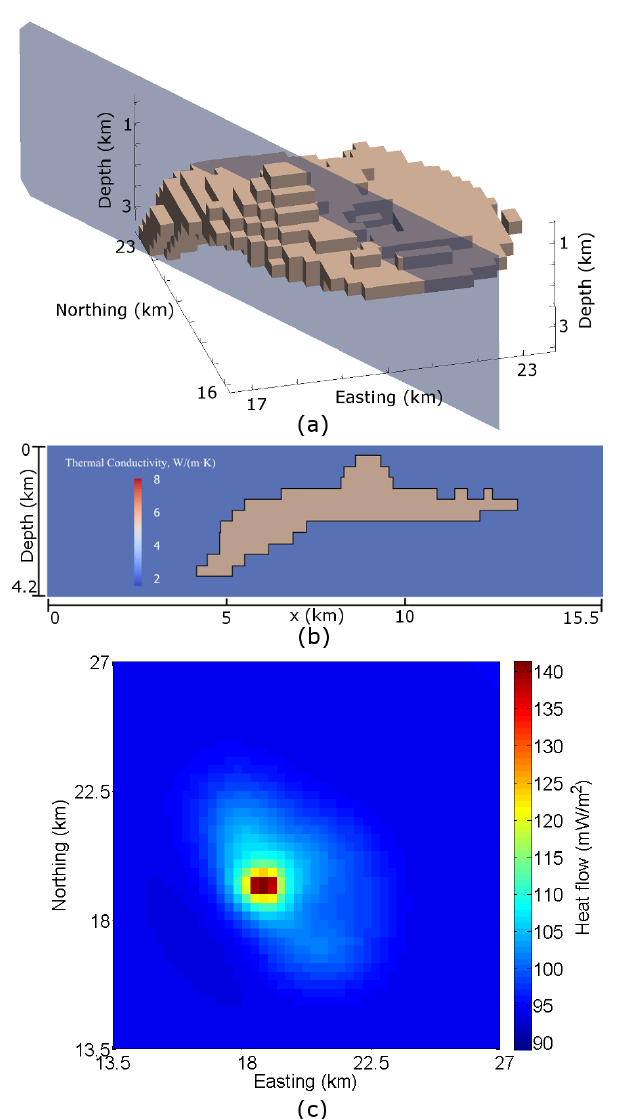
Figure 5. ( a ) A thermal conductivity model constructed from the SEG/EAGE salt model [35]. The blue plane shows the location of the cross-sections shown below. ( b ) A cross-section of the model in ( a ). ( c ) Synthetic heat flow data generated using the model, without noise, demonstrating the effect of the salt body on surface heat